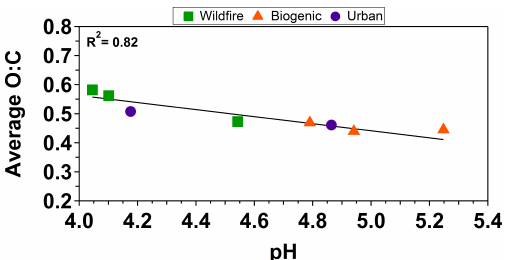
Figure 1. Correlation between cloud water pH and average O:C ratio (negative ion mode, m/z 100–1000) by air mass source influ-